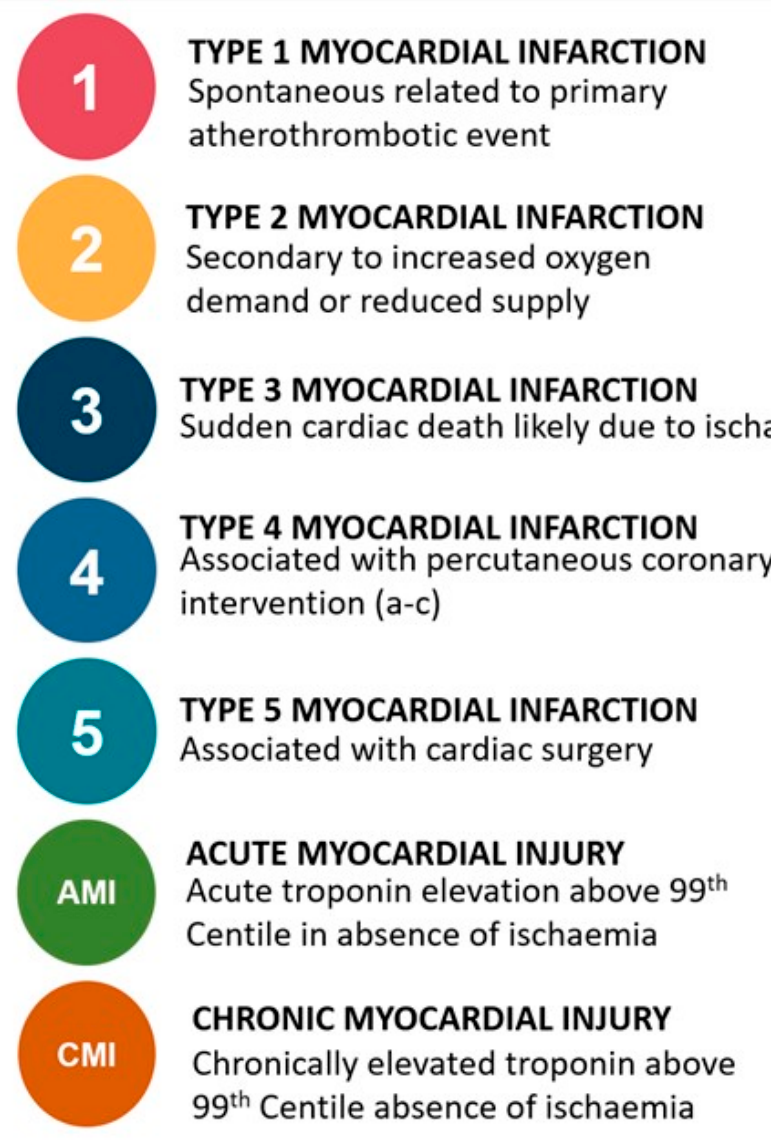
Figure 1. Sub-types of myocardial injury and infarction as per the Fourth Universal Definition of Myocardial Infarction.